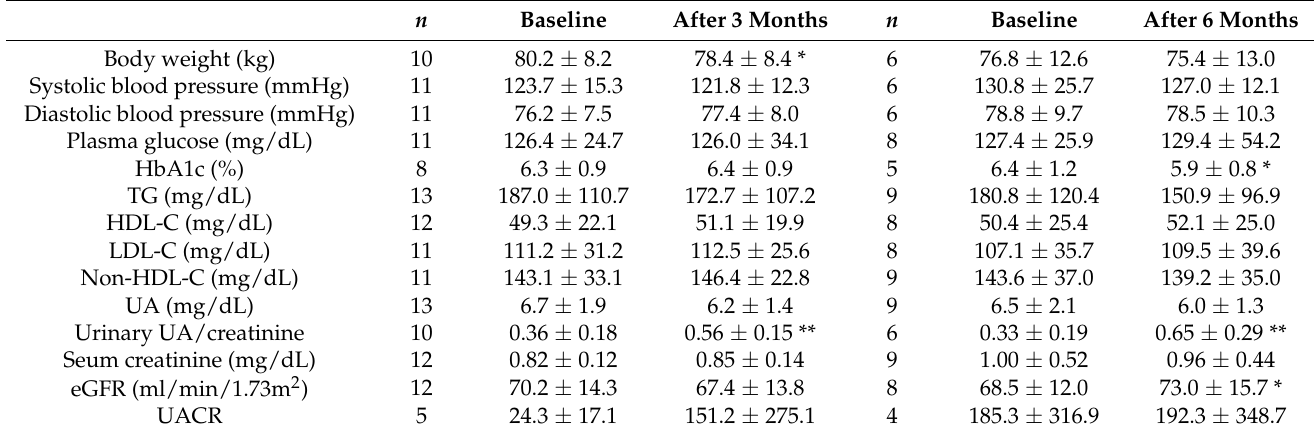
Table 12. Changes in metabolic parameters after the start of dotinurad in patients who had not taken anti-hypertensive and anti-hyperlipidemic drugs and SGLT2 inhibitors ( n = 13). n Baseline After 3 Months